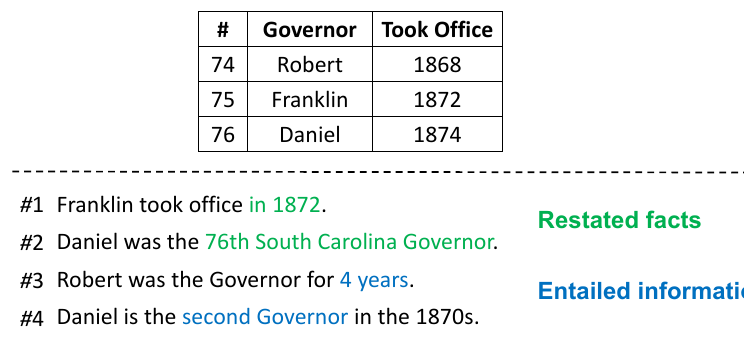
Figure 1. Examples of factual and logical statements.